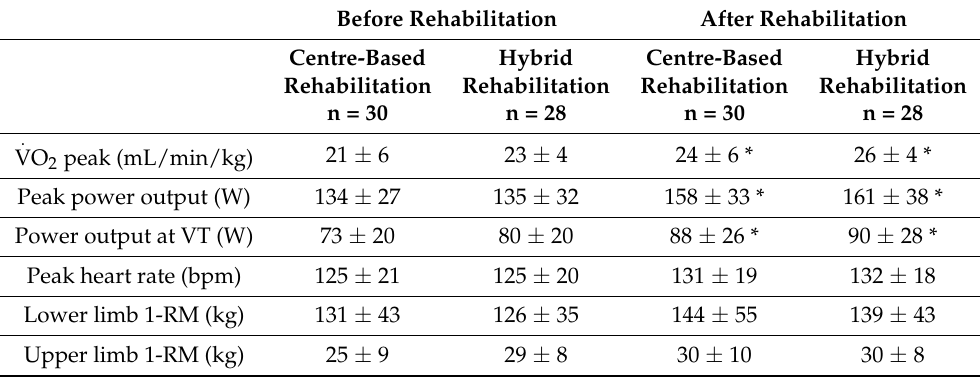
Table 2. Cardiopulmonary variables during exercise tolerance test and the maximum amount of force generated in one maximal contraction